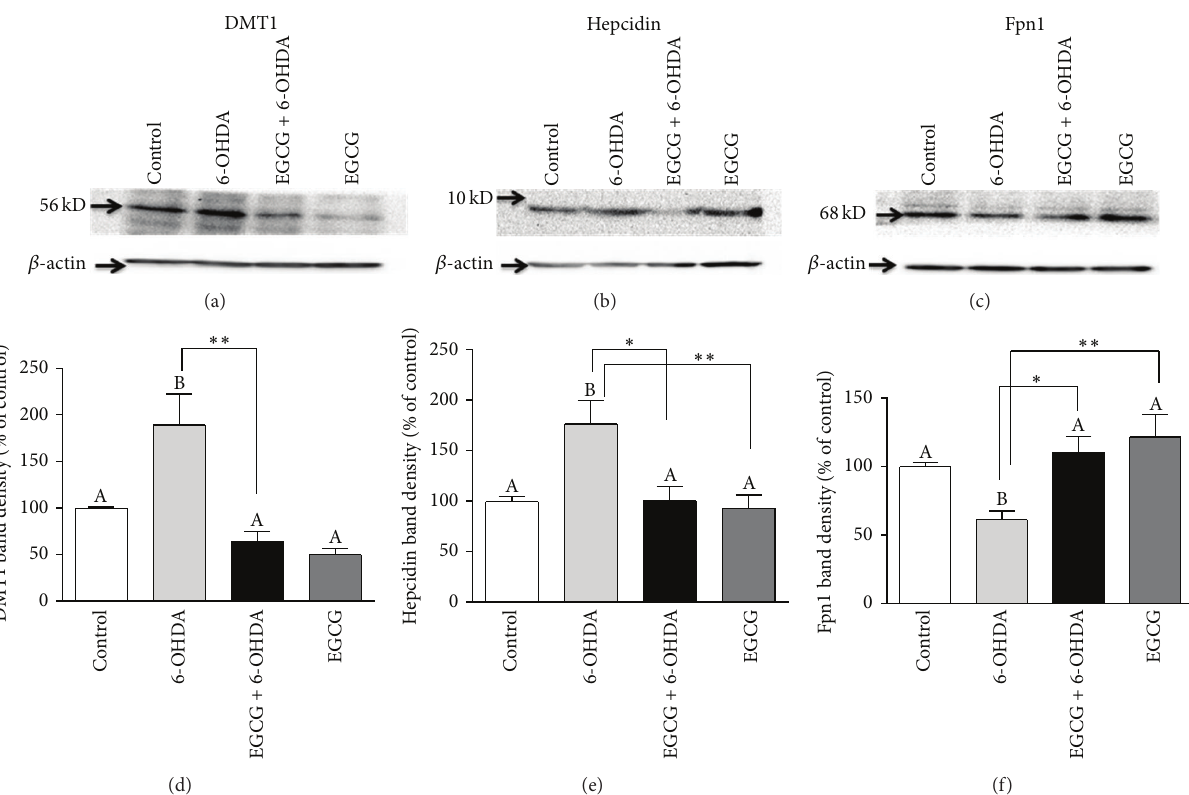
Figure 3: Western blot analysis of the effect of 6-OHDA and EGCG on iron-related protein expression in N27 cells, DMT1 (+IRE) (a), hepcidin (b), and Fpn1 (c), which were normalized by 𝛽 -actin. Cells were treated with EGCG (100 𝜇 M) for 2 h prior to treatment with 6- OHDA (25 𝜇 M) for 24 h. Quantitative data for band intensity are shown in bottom panels, (d), (e), and (f), respectively. Values are mean ± SEM, 𝑛 = 3 . Bars without a common letter differ. ∗ 𝑝 < 0.05 ; ∗∗ 𝑝 < 0.01 .